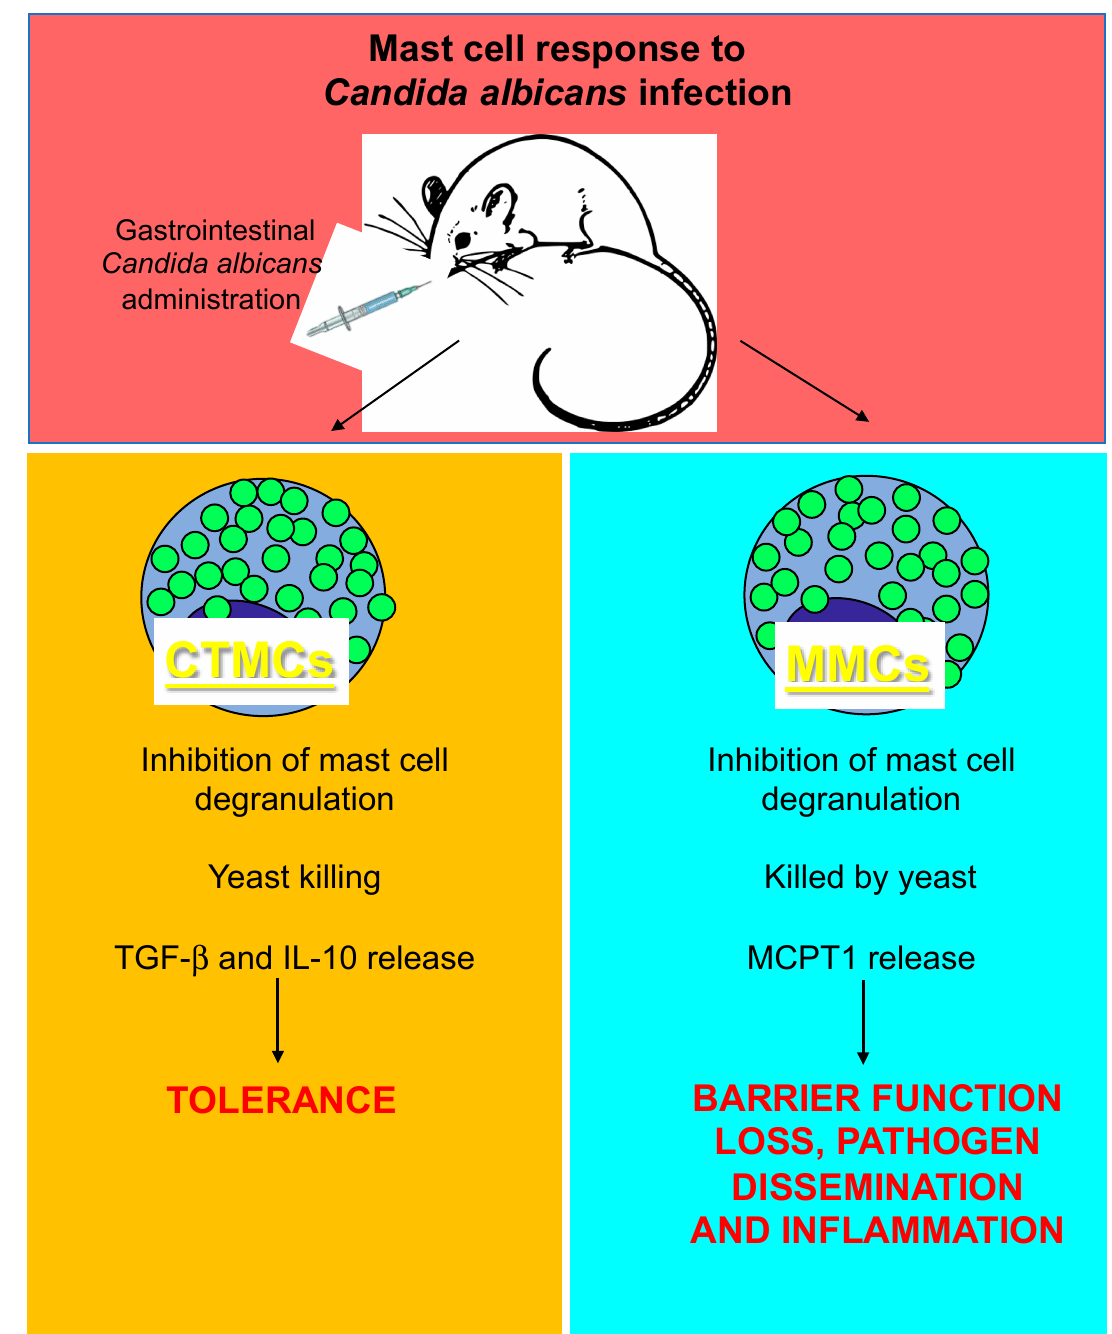
Figure 3. Differential response of mucosal (MMCs) and connective tissue mast cells (CTMCs) to Candida albicans infection in the gut. MCPT1, mast cell protease-1; and TGF- β , transforming growth factor beta.